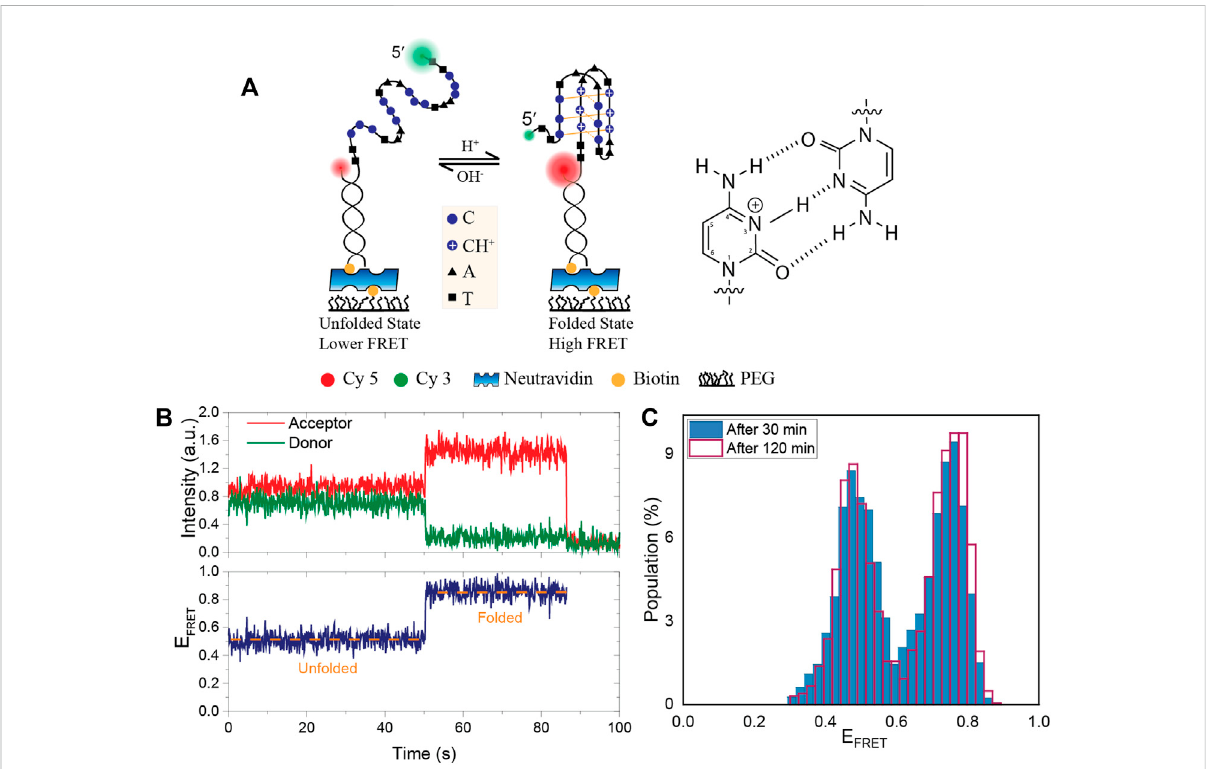
FIGURE 1 Schematic of the DNA construct, an example smFRET time trace and the stability of pH in PCA/PCD oxygen scavenging system. (A) A partial duplex DNA construct were formed by a biotinylated acceptor (Cy5) labeled short strand and a donor (Cy3) labeled long strand that contains an i-motif forming sequence. Folding the DNA into an i-motif brings the donor and acceptor fl uorophores closer together, increasing FRET ef fi ciency. Hoogsteen hydrogen bonds between cytosines and protonation of N3 atom are shown in the schematic. (B) Representative smFRET trace demonstratingatransitionfromtheunfoldedtofoldedstate. (C) TheFRETdistributionatinitialpHof6.3after30 min(blue fi lledbar)and120 min(red lined bar) incubation of PCA/PCD in the chamber. When PCA/PCD is used as the oxygen scavenging system, the distribution essentially remains unchanged over a 120-min imaging period, implying that the pH remains constant to within ±0.05 of the initial